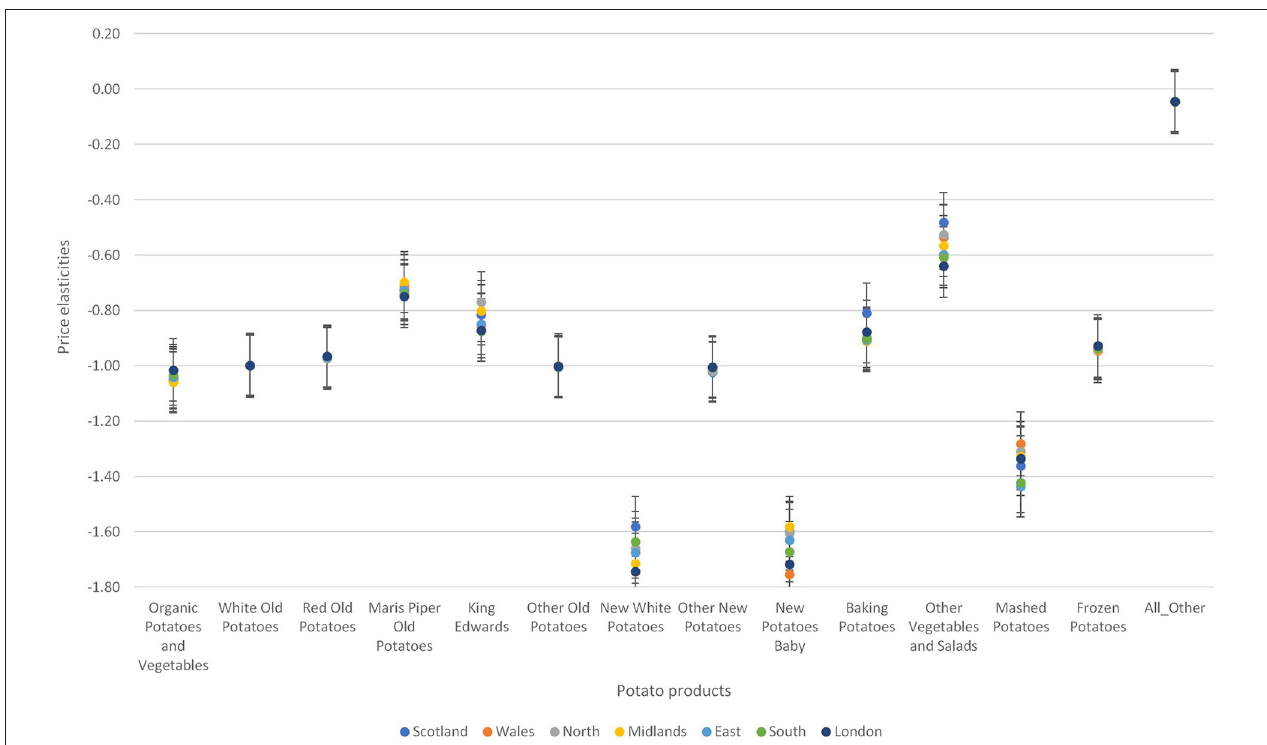
FIGURE 8 | Variations in own price elasticities across different regions in the United Kingdom.